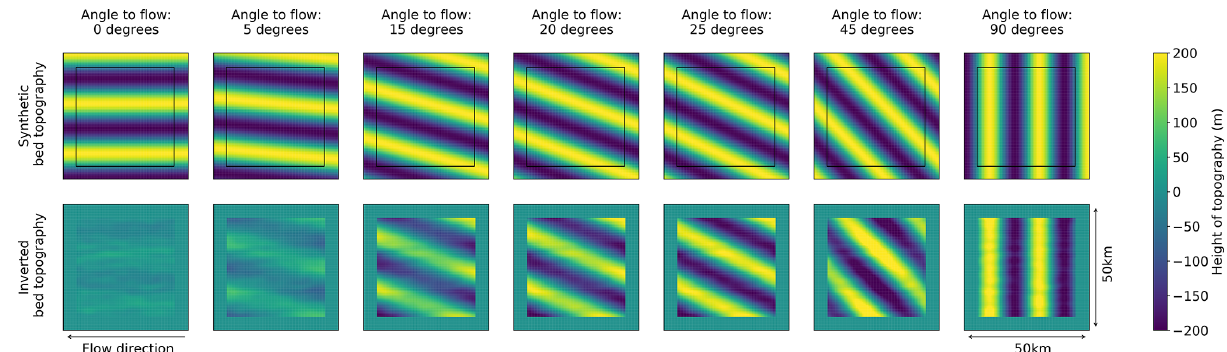
Figure 1. The effect of orientation to flow direction on how well landforms (top row; created synthetically) can be resolved by the inversion. These tests are presented on a 50km by 50km grid, where in the inversion results (bottom row) the outer 5km is greyed out to hide edge effects that will be neglected. In these simulations mean ice thickness h = 2000m, mean slipperiness C is 100, surface slope α is 0.02, amplitude is 200m and wavelength λ is 20km. Landforms at an angle of less than 15 ◦ to the ice flow direction are not well resolved because they fall in the null space of the inversion.